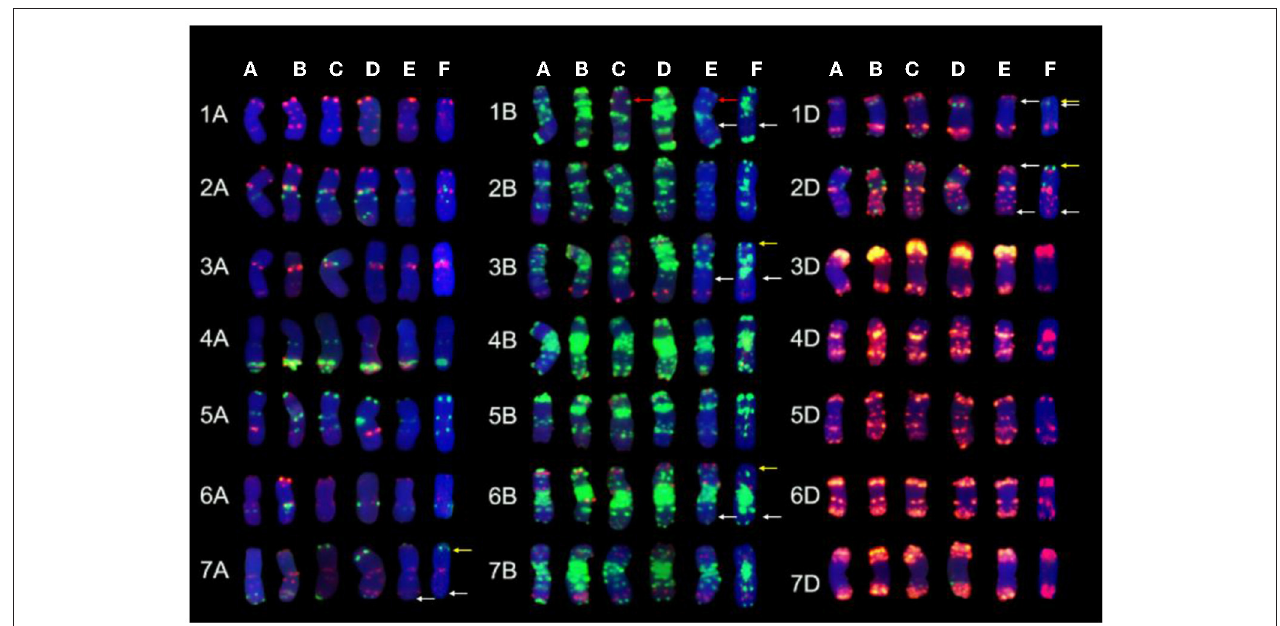
FIGURE 4 | Chromosome comparison of FISH patterns among SN0293-2, SN0293-7, and their parents. (A) SNTE20. (B) YN15. (C) SN224. (D) JM22. (E) SN0293-2. (F) SN0293-7. The red, white, and yellow arrows indicate 1RS, FISH differences of SN0293-2 and SN0293-7, respectively.